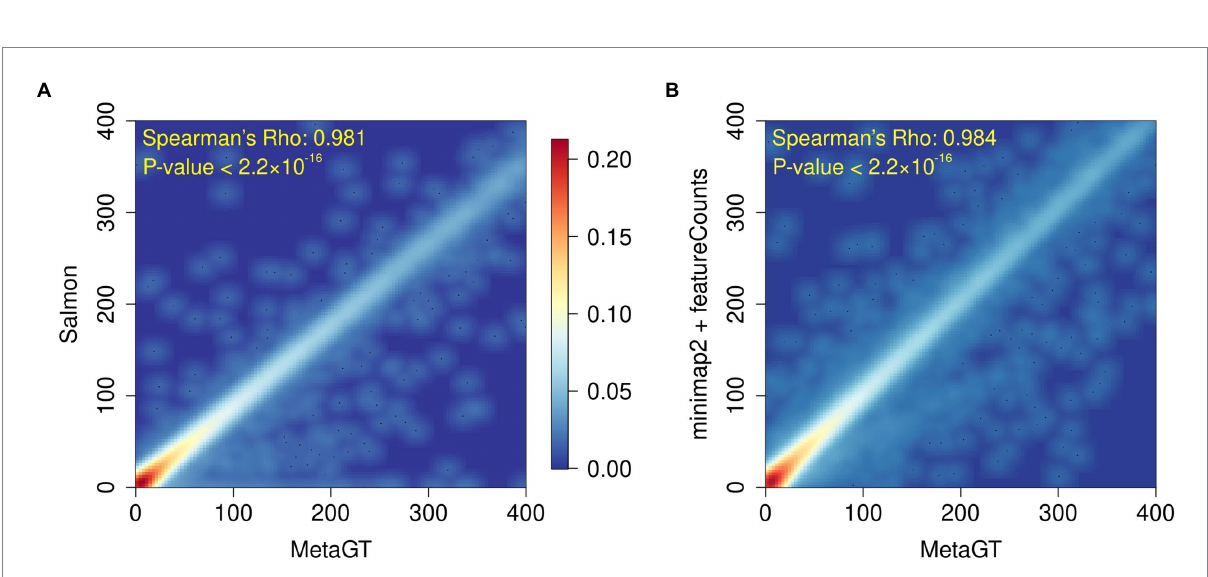
FIGURE 4 Heatmaps showing comparison between gene counts obtained with MetaGT and (A) approach used in the original study (Prodigal and Salmon), and (B) alignment based approach that involves Prodigal, mimimap2 and featureCounts.